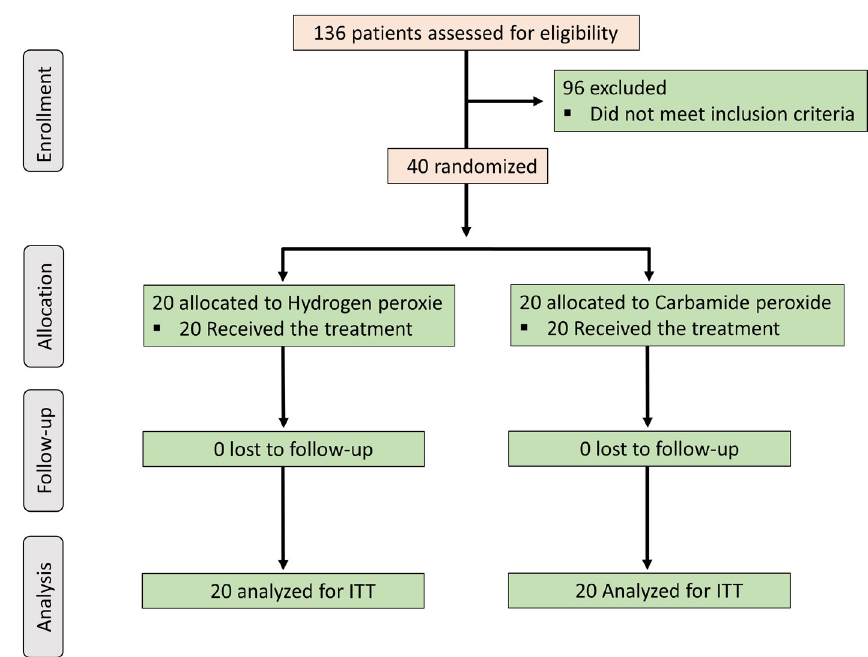
Figure 1- Flow diagram of the clinical